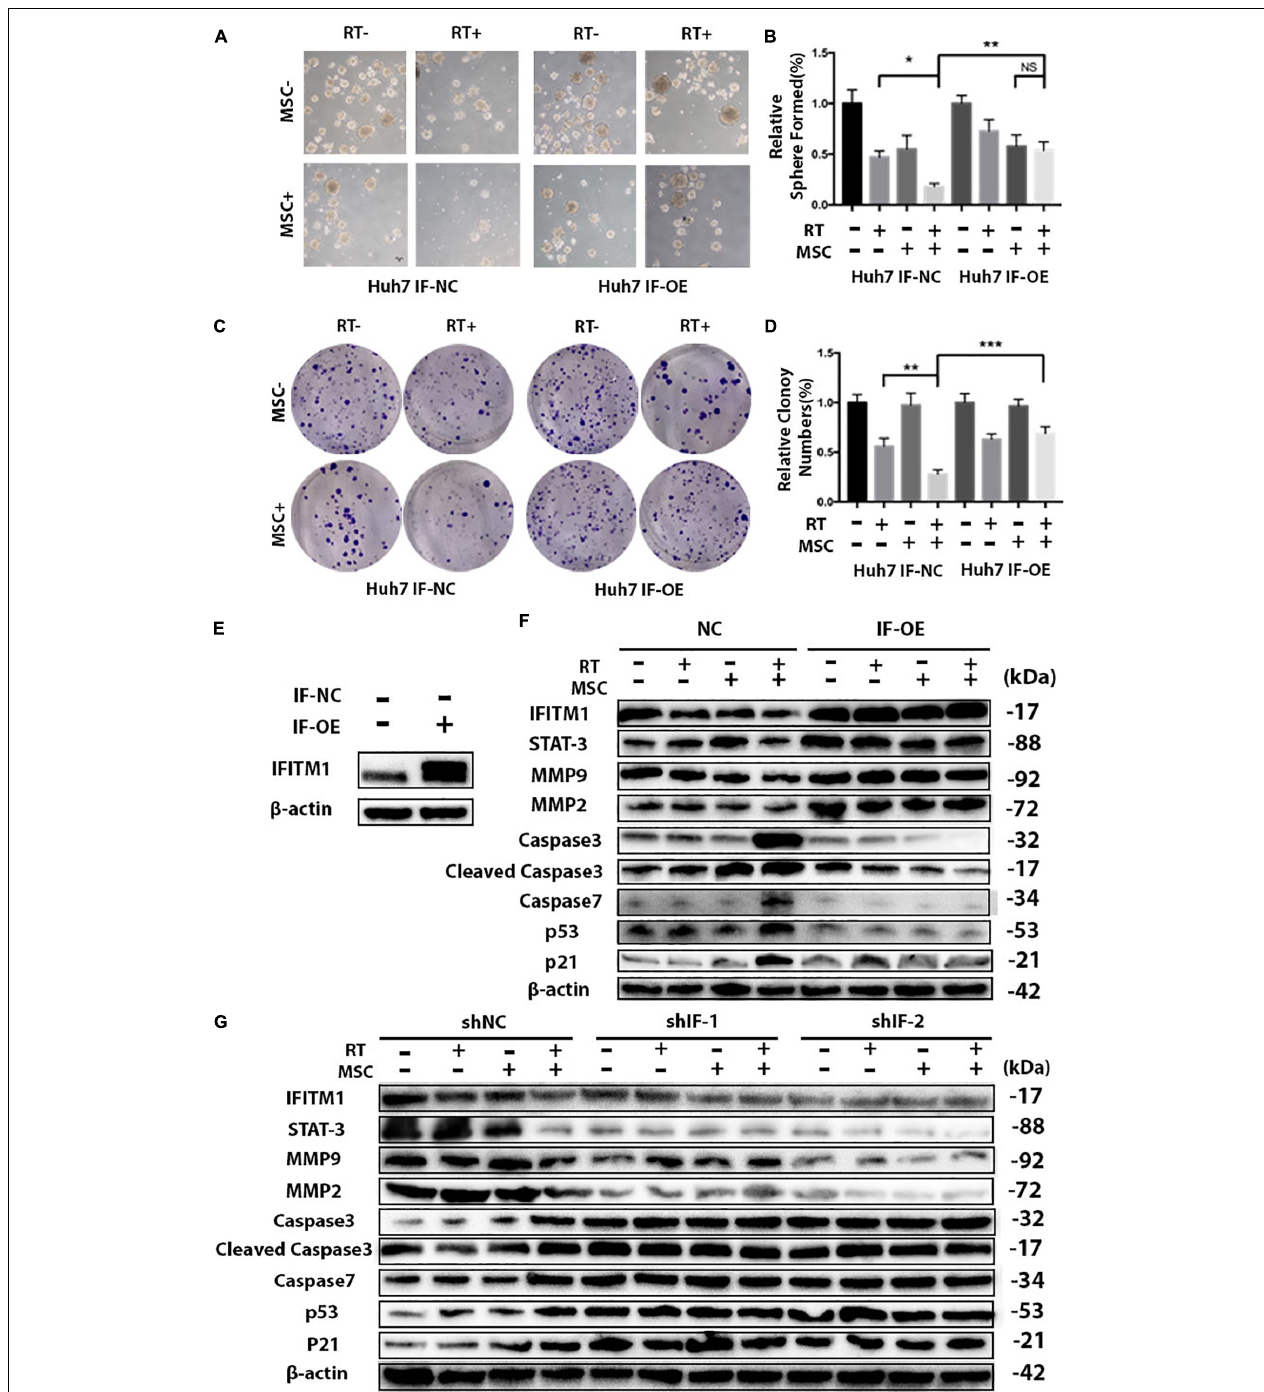
FIGURE 7 | IFITM1 interacts with STAT3 and MMPs and inhibits downstream p53 and Caspases. (A) Control (IF-NC) and IFITM1-overexpression (IF-OE) Huh7 cells treated with RT with or without AT-CM were cultured on ultra-low attachment plates to assess sphere-formation ability. Representative images are shown. (B) The results are expressed as means ± SD of three independent experiments ( ∗ P < 0.05, ∗∗ P < 0.01). (C) The colony-formation assay showed increased tumorigenicity in IF-OE Huh7 cells. (D) The graph shows the mean integrated density of colonies normalized by 100% ( ∗∗ P < 0.01, ∗∗∗ P < 0.001). (E) We overexpressed IFITM1 in Huh7 cells using lentivirus-mediated transcription, and the expression level of IFITM1 was assessed by Western blot analysis using β -Actin as loading control. (F) IF-NC and IF-OE Huh7 cells treated with RT with or without AT-CM and cell lysates were isolated to probe with antibodies indicated. Protein level was determined by western blot with β -actin used as the loading control. Representative images were shown. (G) Cell lysates were isolated from HCC Huh7 cells after knocking down IFITM1, and the protein levels were probed with antibodies indicated. β -actin used as the loading control. Representative images were shown.